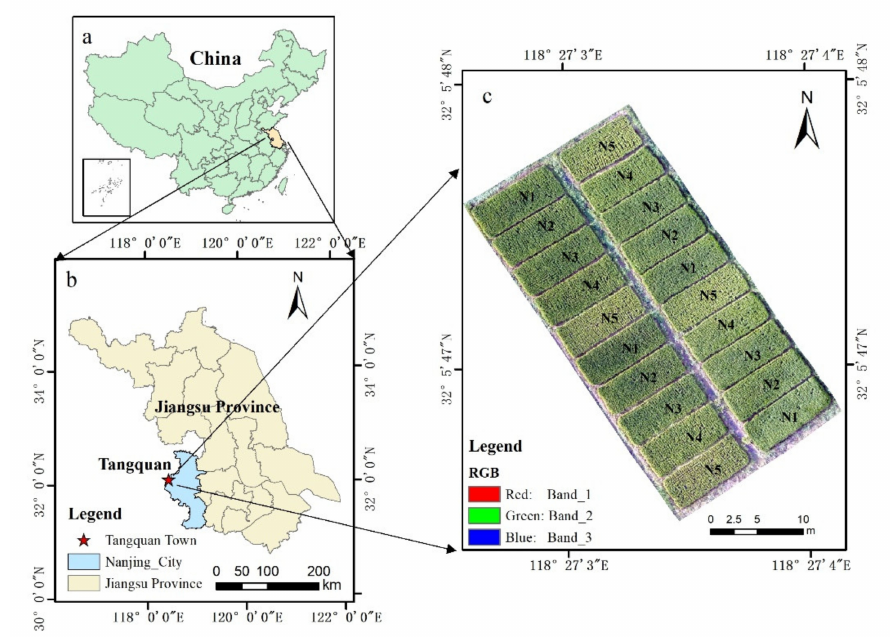
Figure 1. Geographic location of the research area and a UAV image of the experimental plots with 5 fertilization treatments (( a ), the location of Jiangsu Province in China; ( b ), the location of Nanjing City in Jiangsu Province and the location of Tangquan Town in Nanjing City; ( c ), a UAV image of the experimental